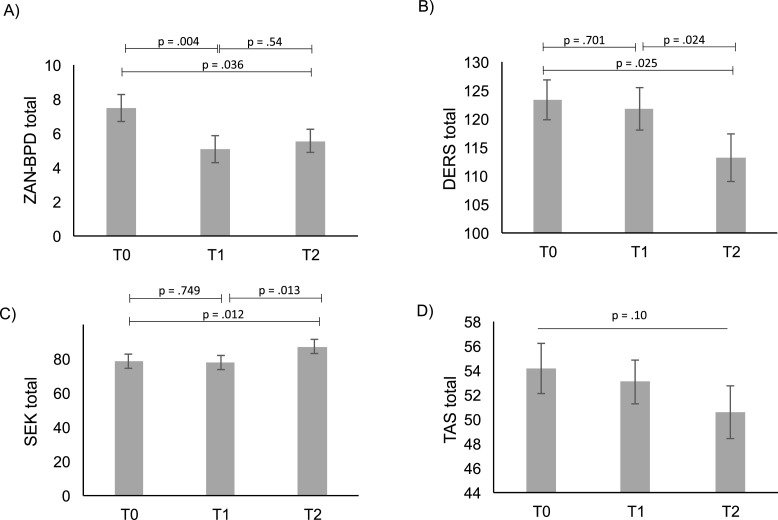
Diagnostic interview and self-assessment results at T0, T1, and T2. A) BPD psychopathology significantly (p < .05 uncorrected) improved from T0–T1 and from T0–T2. B) Difficulties with the Emotion regulation Scale (DERS) total score significantly3 reduced from T1–T2 and from T0–T2, indicating that difficulties in emotion regulation decreased over time. C) Self-assessment of the emotional competencies (Selbsteinschaetzung Emotionaler Kompetenzen, SEK) total score significantly increased from T1–T2 and from T0–T2, showing an increase in emotional competence over time. D) A trend in reduction of alexithymia was observed, but did not pass the significance test. Error bars represent standard error of the mean (SEM).